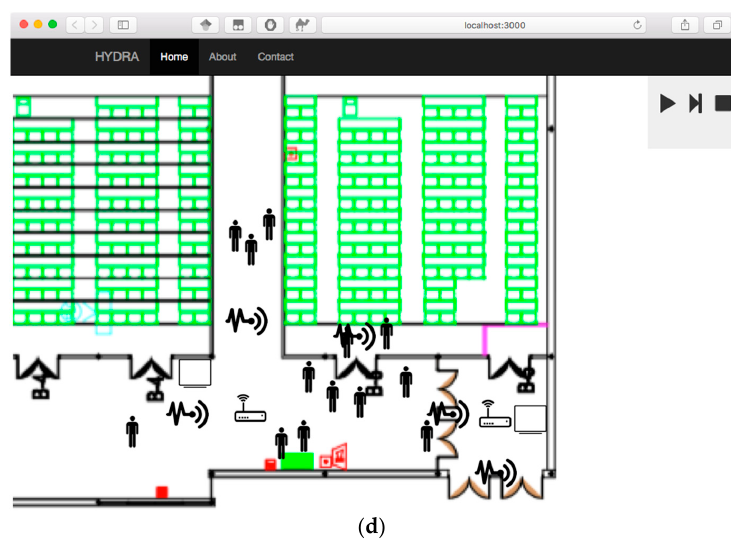
Figure 13. Simulator’s user interfaces. ( a ) Basic configuration. ( b ) Simulation execution and control. ( c ) Simulation design. ( d ) Results presentation (temporal animation).